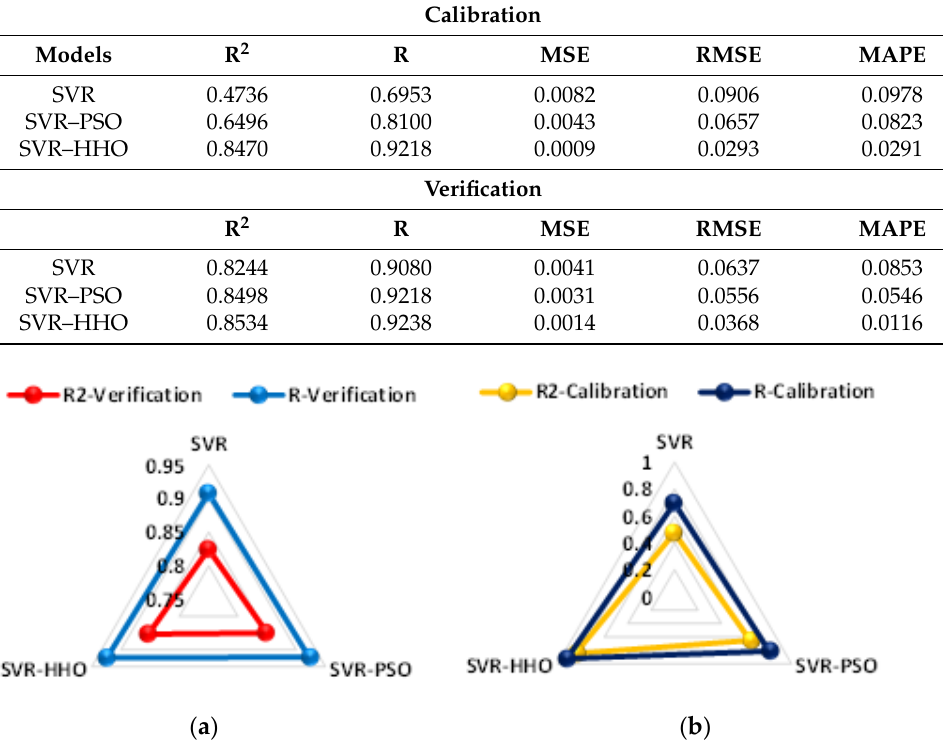
Figure 19. Radar plot for GRG in the ( a ) calibration and ( b ) verifications stages.